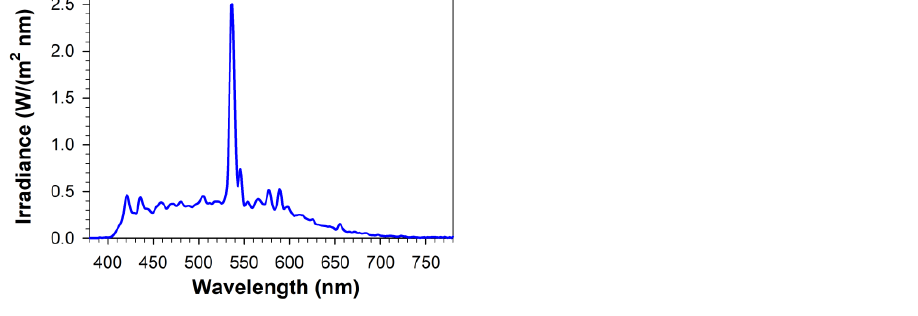
Figure 8. Irradiance spectrum of light used for photodegradation of lipofuscin and exposure to light of ARPE-19 cells. of ARPE-19